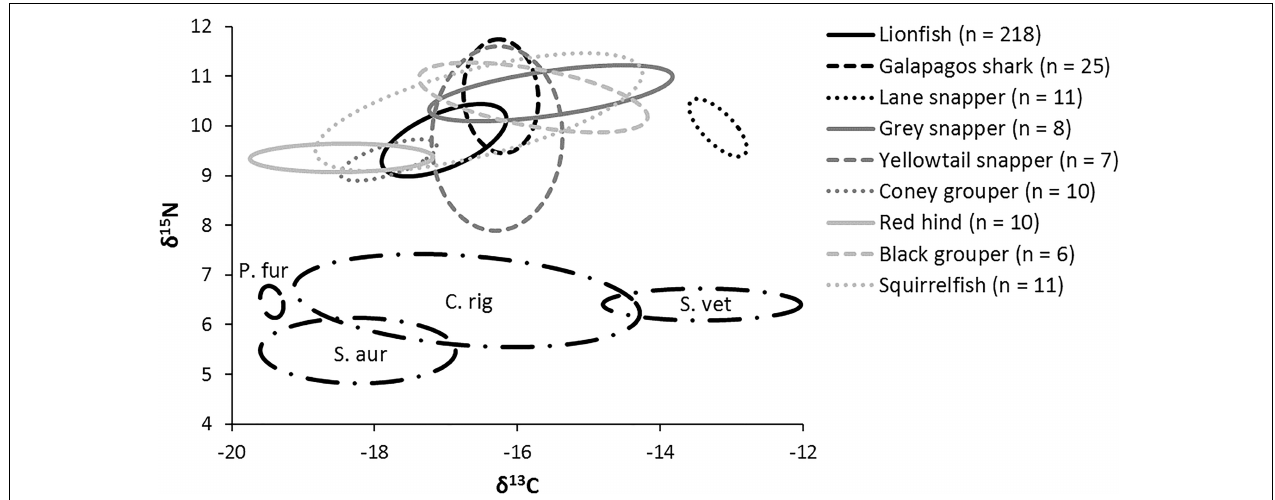
FIGURE 9 | Isotopic niche of individual mesopredators and four primary consumers (black dashed lines). P. fur, Atlantic creolefish ( n = 12); C. rig, Red night shrimp ( n = 12); S. vet, Queen parrotfish ( n = 10); S. aur, Redband parrotfish ( n = 11).